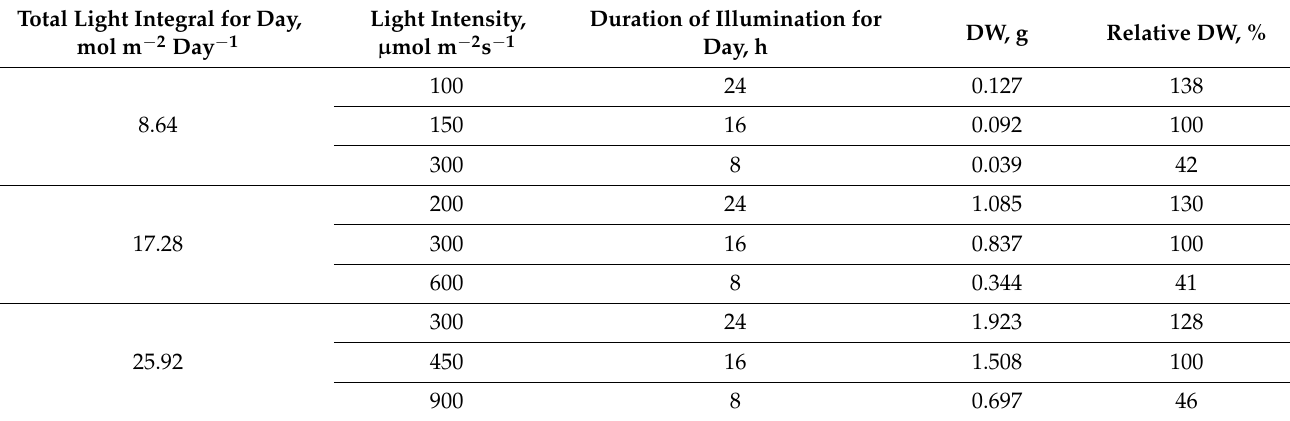
Figure 9. Dependences of the absolute ( a ) and relative ( b ) DW on photoperiod (t light ) simulated by models under various intensities of the illumination. Relative DW was calculated as the percentage from the dry weight in the variant with 16 h (light):8 h (dark) illumination regime (the control variant). Simulated DW were estimated after 32 days of cultivation; initial DW (zero day) was assumed as the 0.01 g. Table 2. Dry weights (DW) of plants which were simulated by the model after 32 days of cultivation at various combinations of light intensity and duration of illumination during the day. Relative DW was calculated as a percentage from the control DW in plants cultivated under 16 h (light):8 h (dark) illumination regime.